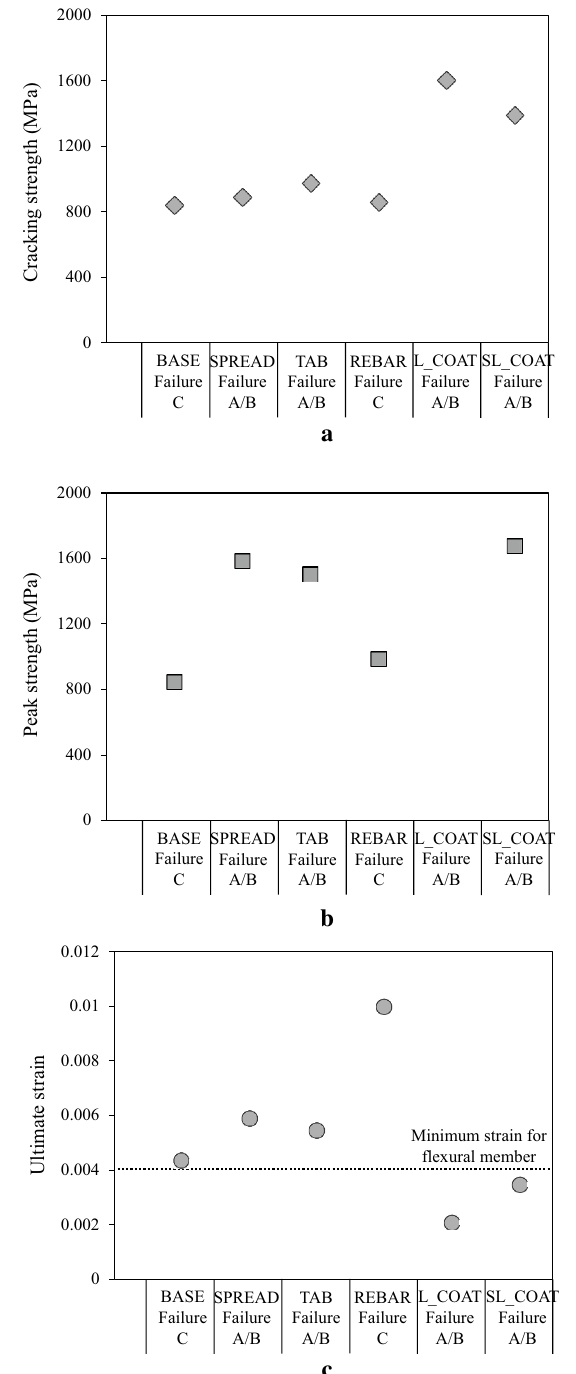
Fig. 9 Comparison of average cracking strength, average peak strength and average ultimate strain of TRM test specimens. a Effect of anchorage methods on cracking strength, b Effect of anchorage methods on peak strength, c Effect of anchorage methods on ultimate strain.